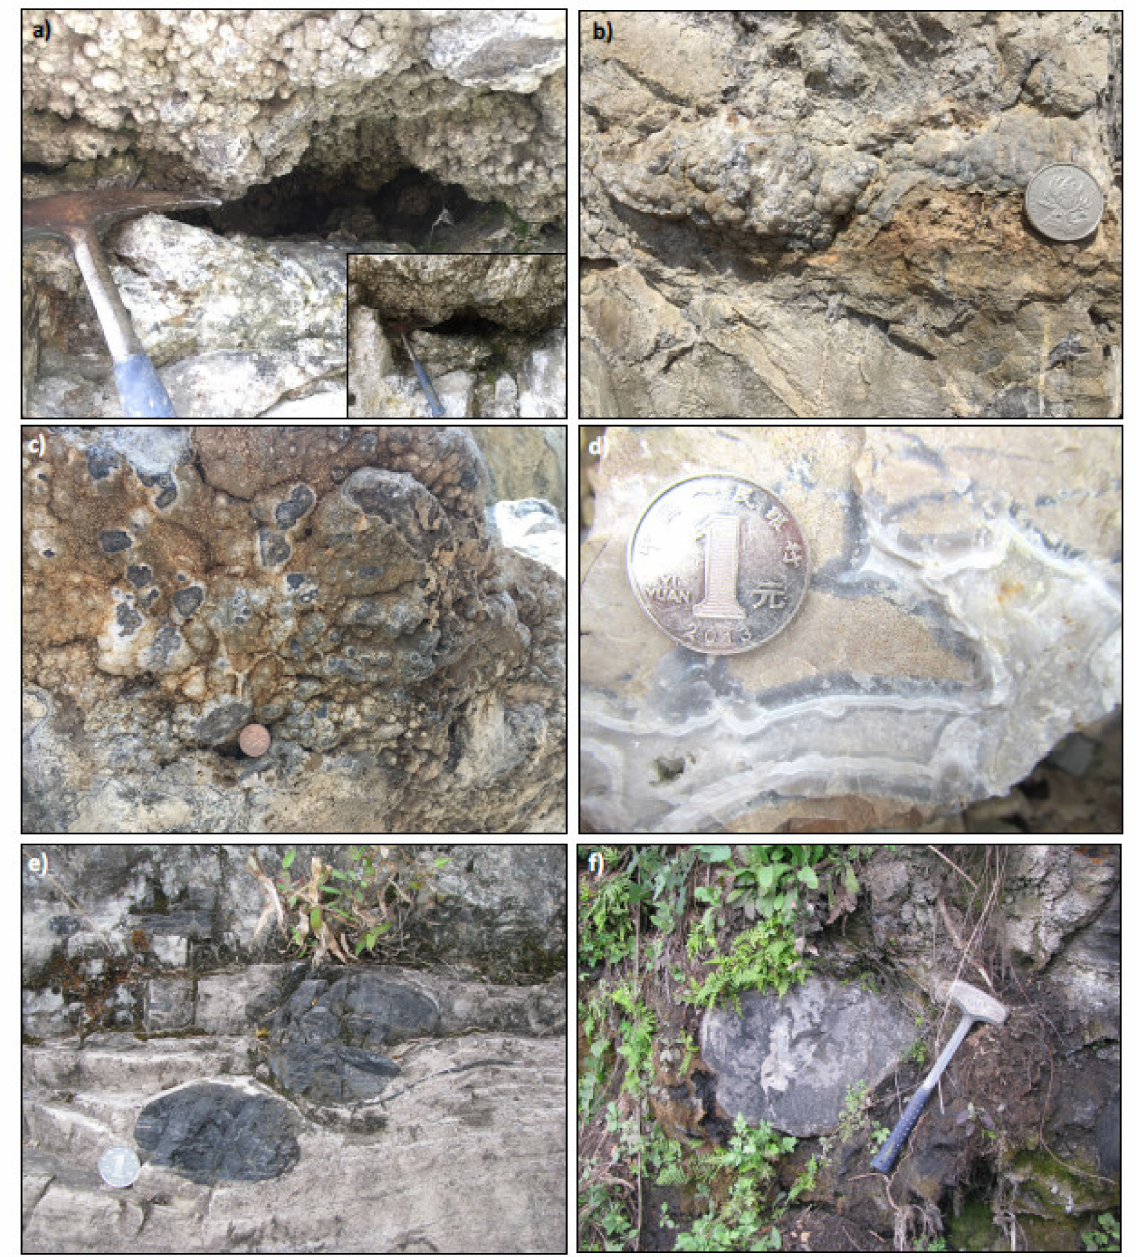
Figure 1. Outcrop images of quartz botryoids in Doushantuo cap carbonate, Member 1. ( a ) Cavity lined with a crust of botryoidal quartz (YG1801, Jiulongwan section). ( b ) Exposed cavity with quartz botryoids (YG1802; Jiulongwan section). ( c ) Another cavity with blackened carbonate caps under broken botryoids (Jiulongwan section). ( d ) So-called ‘sheeted cracks’ of quartz botryoids with fine curvi-linear laminations inside beige carbonate (DO1706; Beidoushan section). ( e ) Outcrop of black chert concretions in the Dengying dolomite (Three Gorges area) and ( f ) shows an outcrop of carbonate concretion in black shale from the Niutitang Fm (Three Gorges